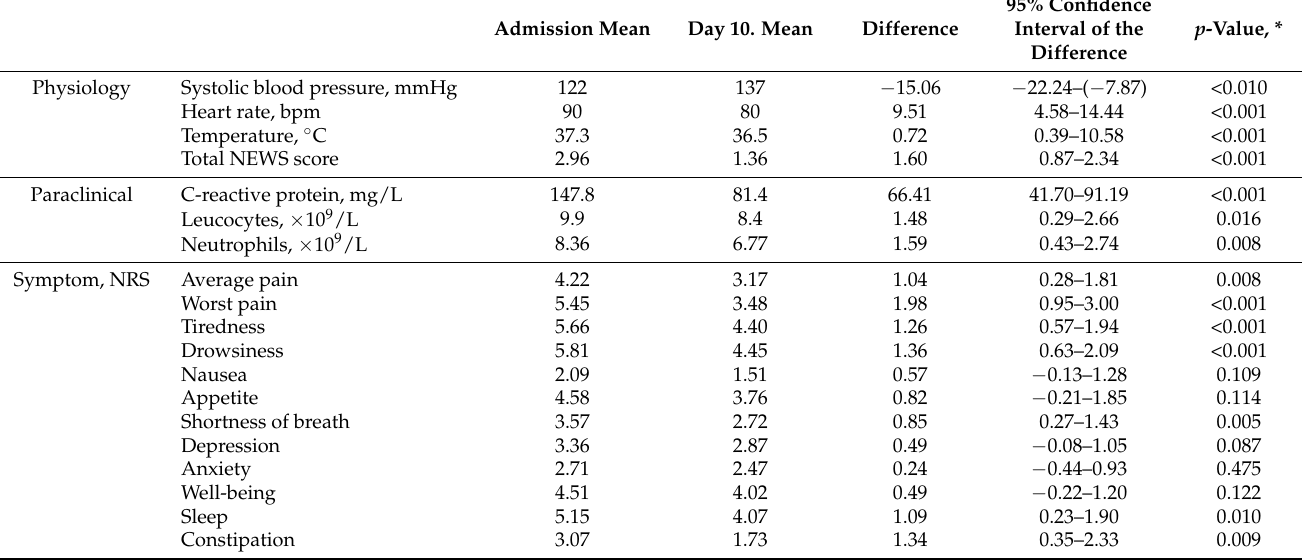
Table A1. Course of disease during stay infection group, n = 62.